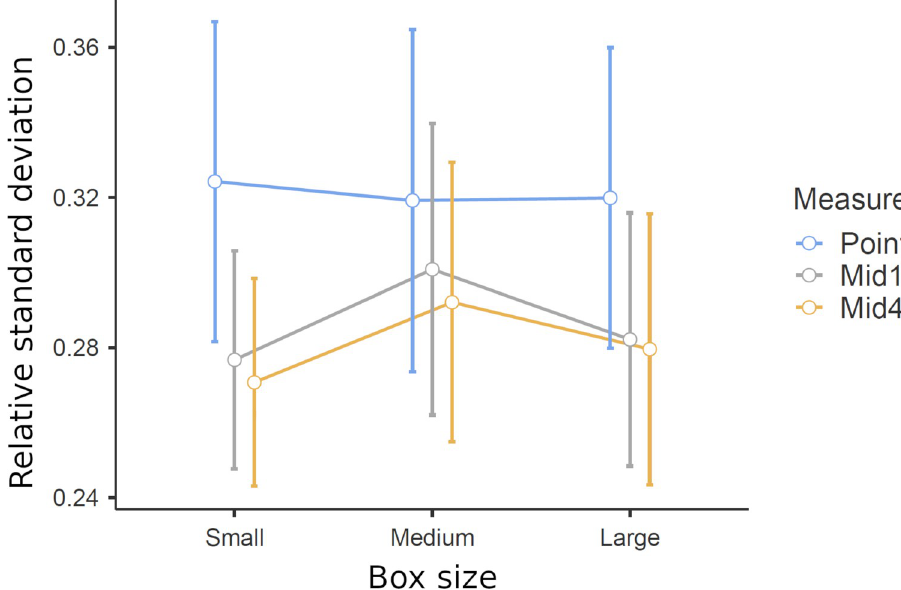
Fig 7. Relative standard deviation of box judgments depending on measure and size of the box. Whiskers indicate 95%-CI.